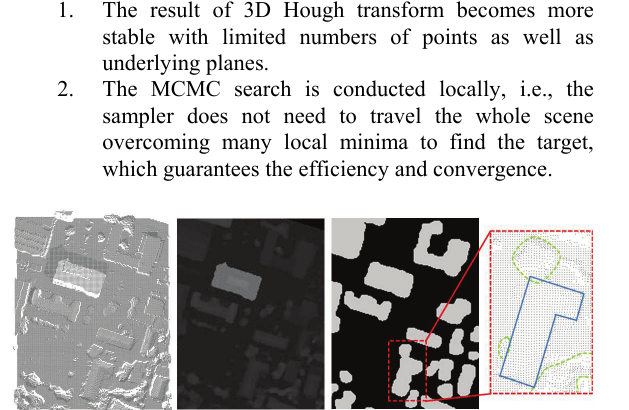
Figure 1. Pre-segmentation: the given point cloud (left) is converted into a raster image (middle). After morphology processing blobs containing individual buildings are labeled and segmented (red dashed rectangle).